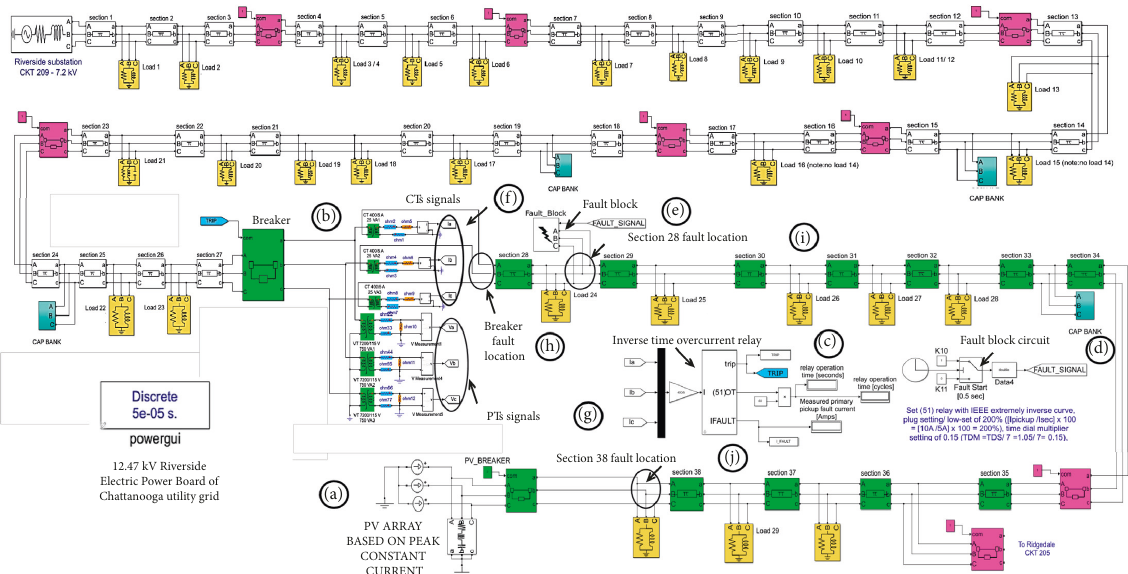
Figure 4: Three-line diagram in MATLAB/Simulink model with (a) power grid circuit, (b) breaker, (c) inverse time overcurrent relay, (d) fault block circuit, (e) fault block, (f) current and (g) potential transformers, and (h–j) fault